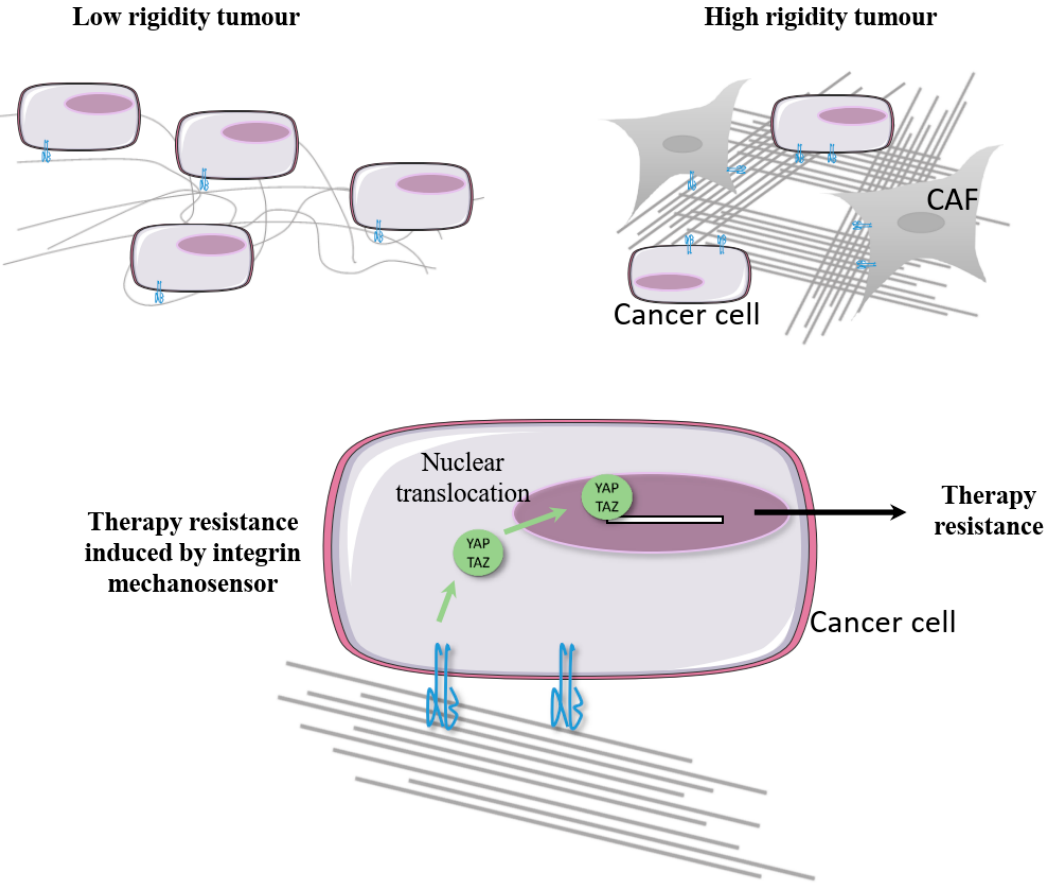
Figure 4. Hypothetic model showing how integrins may trigger therapy resistance in stiff micro- environmental niches. Therapy-resistant tumors are often characterized by an increase in matrix stiffness. Cancer-associated fibroblast (CAF) integrins (mainly α 5 β 1 integrin) generate mechanical forces that increase ECM protein assembly and matrix rigidity. In cancer cells, the sensing of CAF- generated tension by integrins activates transcriptional co-regulators YAP and TAZ and their translocation to the nucleus. The transcriptional response leads to therapy resistance (adapted from [186]).